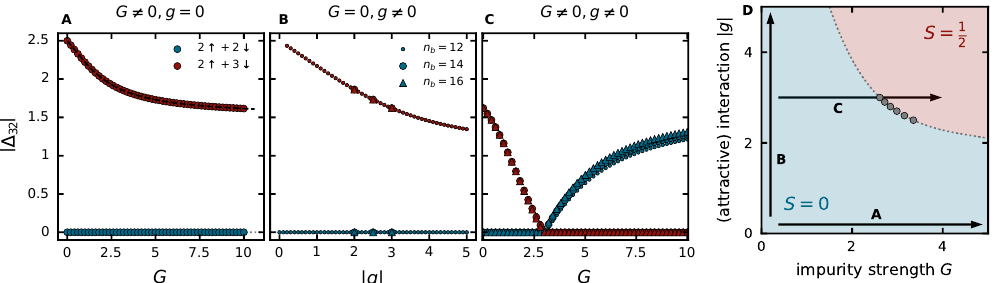
| between Figure 11: Few-body system interacting with an impurity. The gap | ∆ 32 the ground-state energies in the 2 ↑ + 2 ↓ and 2 ↑ + 3 ↓ sectors. In panel A (no fermion-fermion interactions, i.e., g = 0) and B (no impurity, i.e., G = 0) the gap is always open. If G ̸ = 0 and g ̸ = 0 (panel C) the ground state of the system may transition from the S = 0 to S = 1 sectors. (D) Few-boy phase diagram in the g – G 2 → ∞ plane, data points are obtained by extrapolating to the limit n b